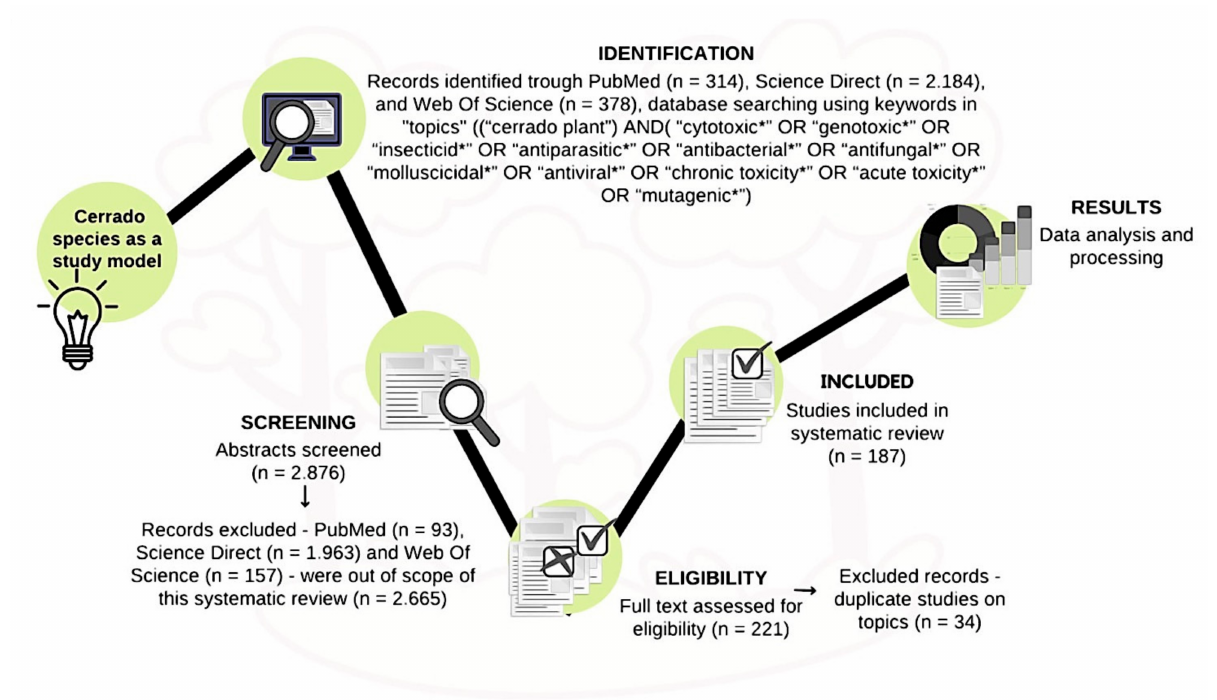
Figure 7. The experimental workflow used in the present review to identify articles containing information about Cerrado plants with toxic bioactivities. The workflow involved the identification, screening, eligibility assessment, and inclusion of available manuscripts from several online databases. During the search for the terms in the databases, the asterisk (*) was used as a wildcard and enabled the search of any letters in its